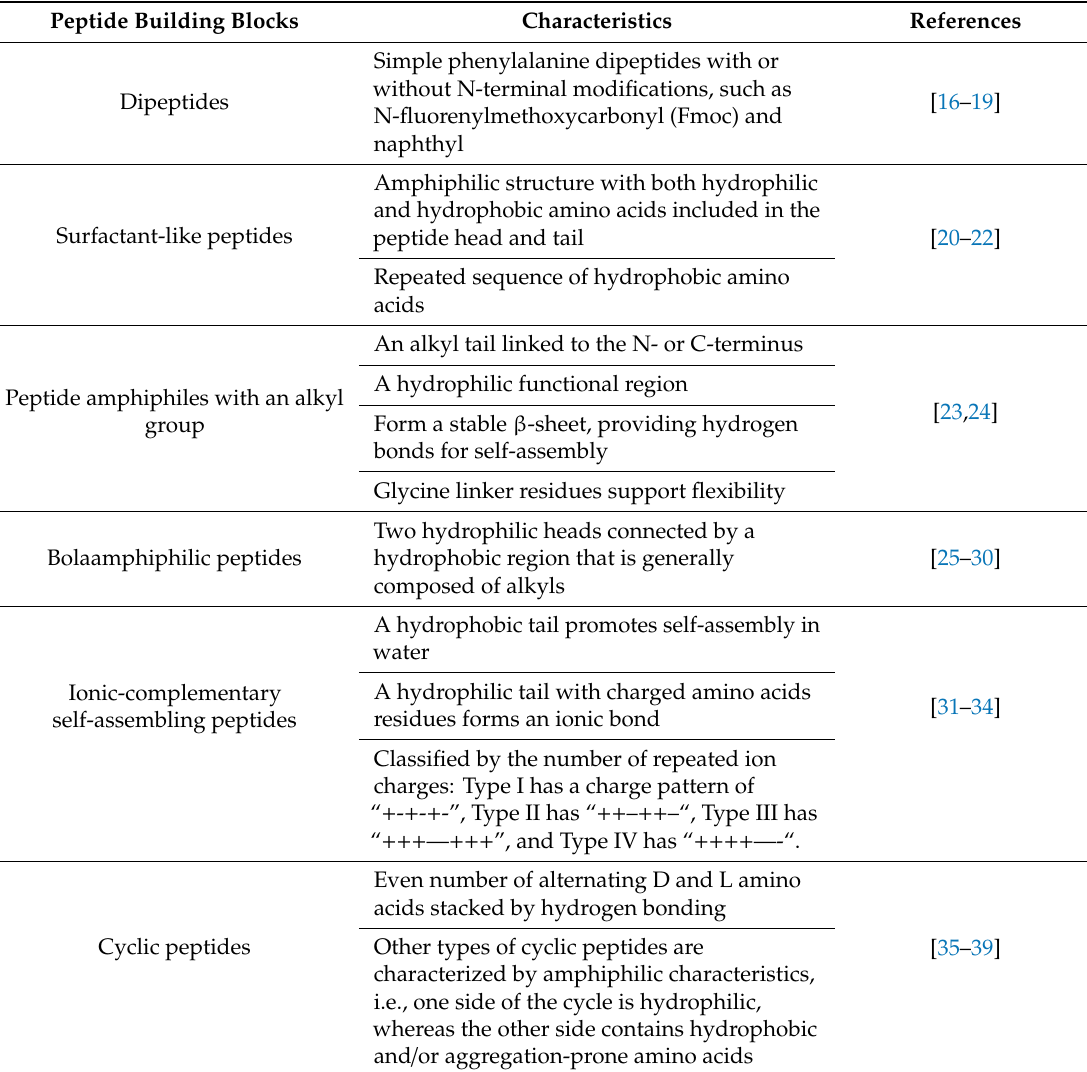
Table 1. Peptide building blocks that